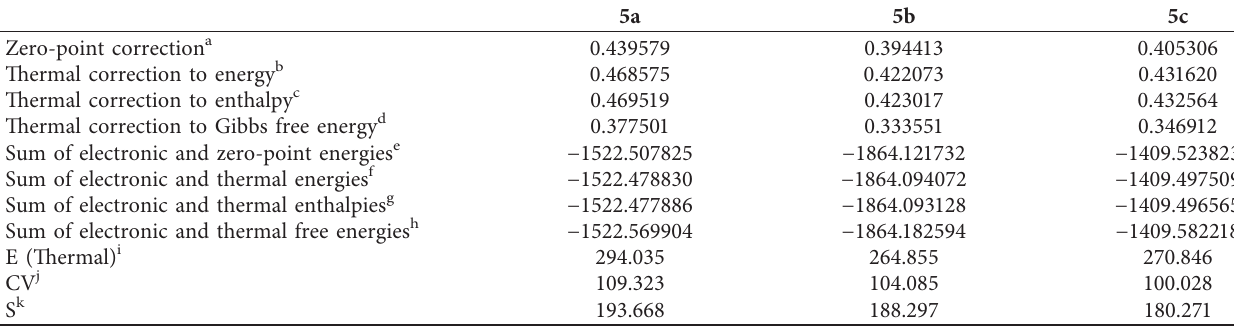
Table 13: Thermodynamic parameters of the 5a , 5b , and 5c molecules using the B3LYP/6-311+G(d)